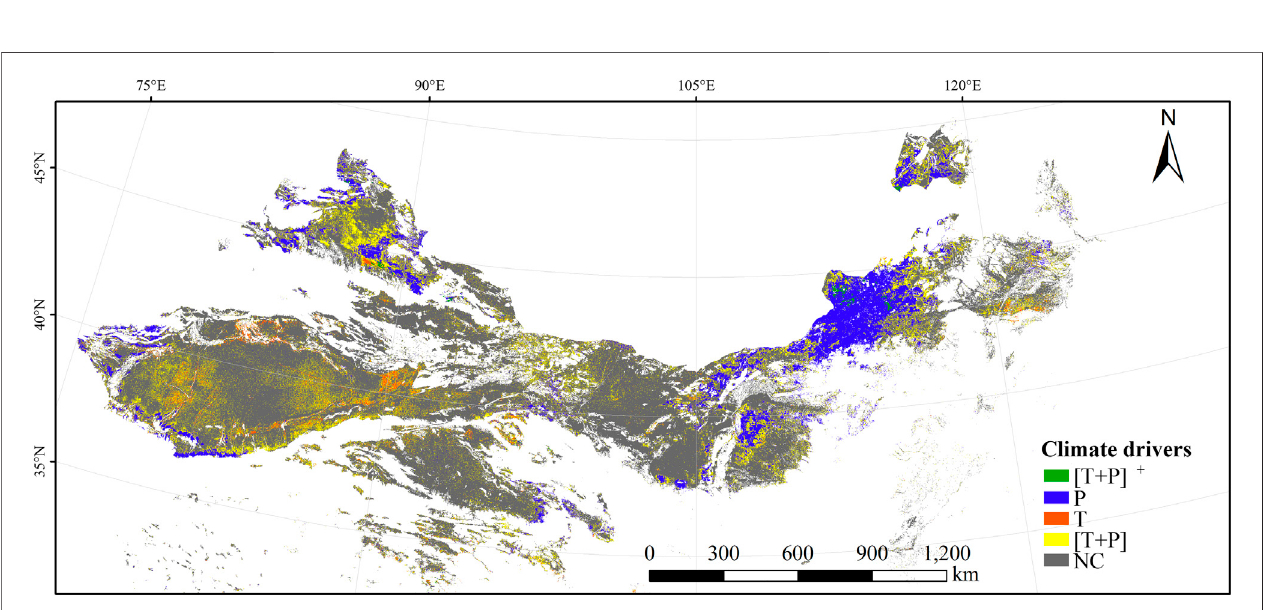
Frontiers in Environmental Science |